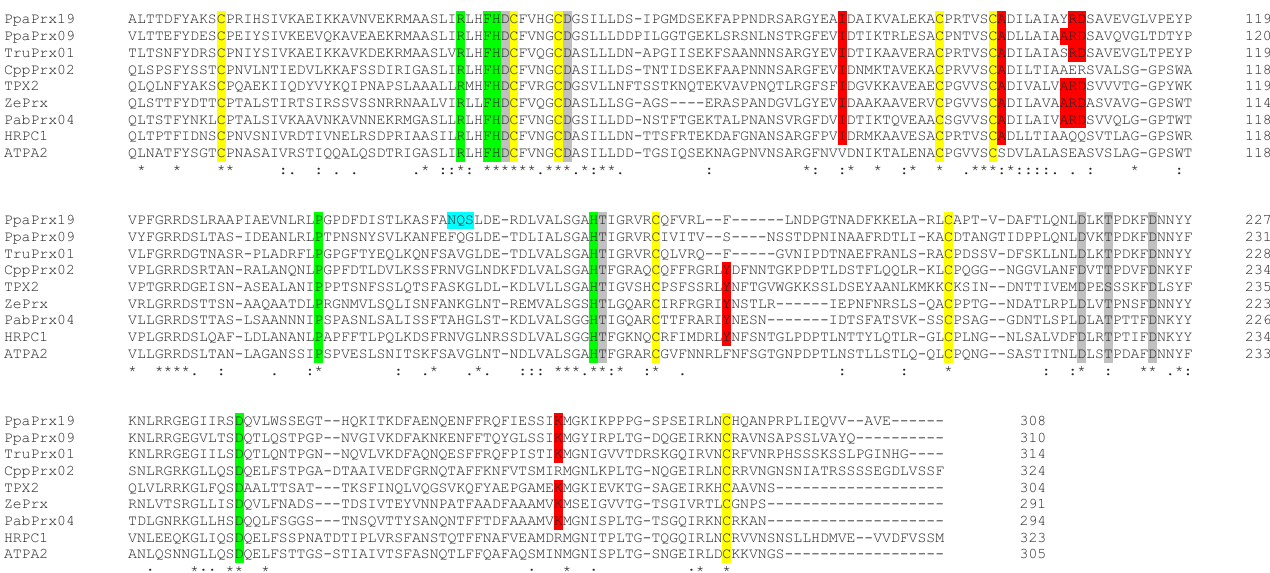
Figure 3. PpaPrx19 shows most of residues characteristic of syringyl peroxidases. Amino acid alignment of mature peroxidase sequences, including those purified in this study (PpaPrx19), Arabidopsis thaliana ATP A2 (CAA68212), horseradish peroxidase HRPC1 (AAA33377), Picea abies PabPrx04 (CAH10839), Zinnia elegans ZePrx (CAI54302), Solanum lycopersicum TPX2 (AAA65636) and the three peroxidases that show the highest identity to PpaPrx19 (PpaPrx09, TruPrx01 and CppPrx02). Conserved residues important for catalytic mechanisms are shaded in green, the calcium-binding sites are shaded in gray, the S-S bridge-forming cysteines are shaded in yellow, putative N -glycosylation site of PpaPrx19 is shaded in blue and structural determinants of syringyl peroxidases are shaded in red. Consensus symbols: ‘*’ indicates fully conserved residues, ‘:’ indicates conserved substitutions and ‘.’ indicates semiconserved residue substitutions.